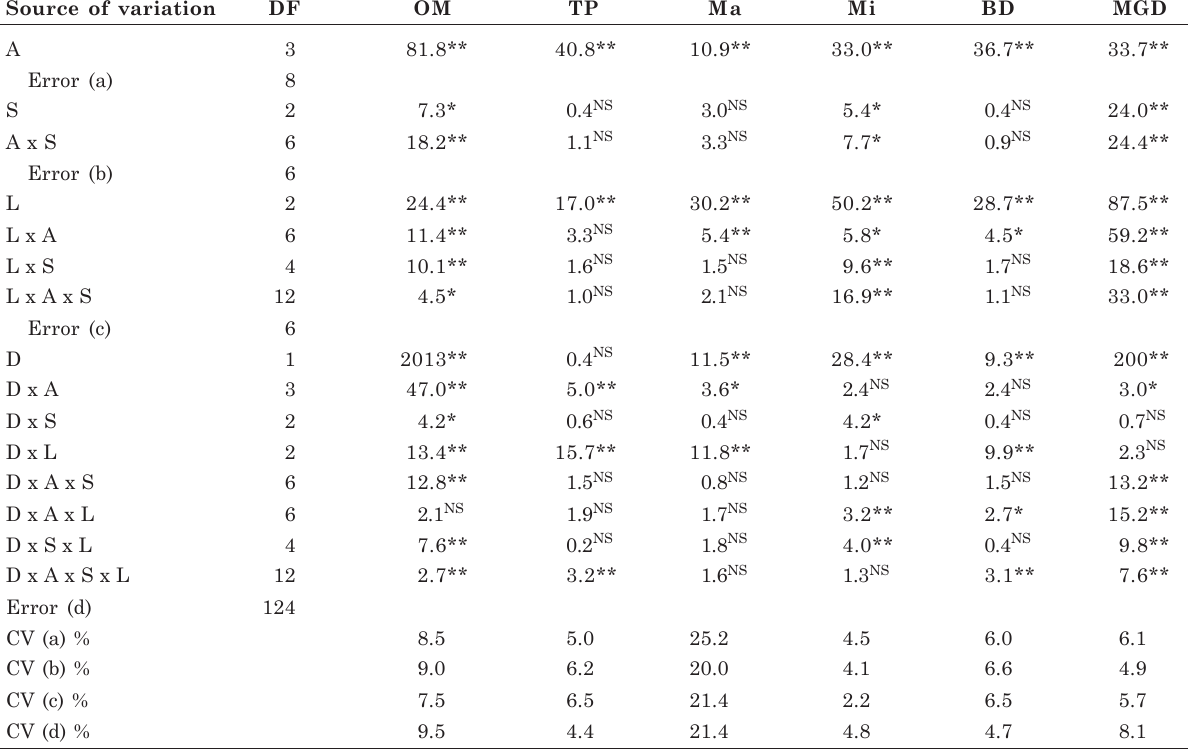
Table 1. ‘F’ values in the analysis of variance for organic matter (OM), total porosity (TP), macroporosity (Ma), microporosity (Mi), bulk density (BD) and aggregate stability by mean geometric diameter (MGD) for different ages of the coffee plantation (A), slopes (S), sampling location (L) and depth (D) in a Red- Yellow Latosol